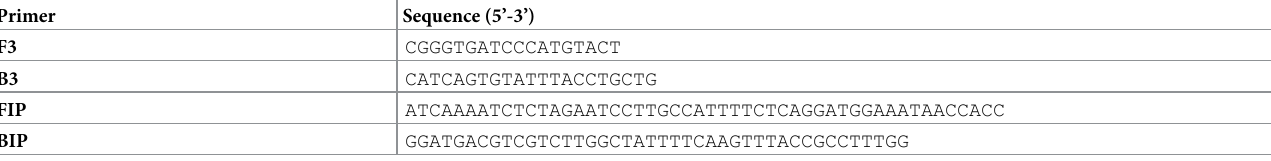
Table 1. Nucleotide sequences of the set of LAMP caf1 primers designed in this study. Primer Sequence